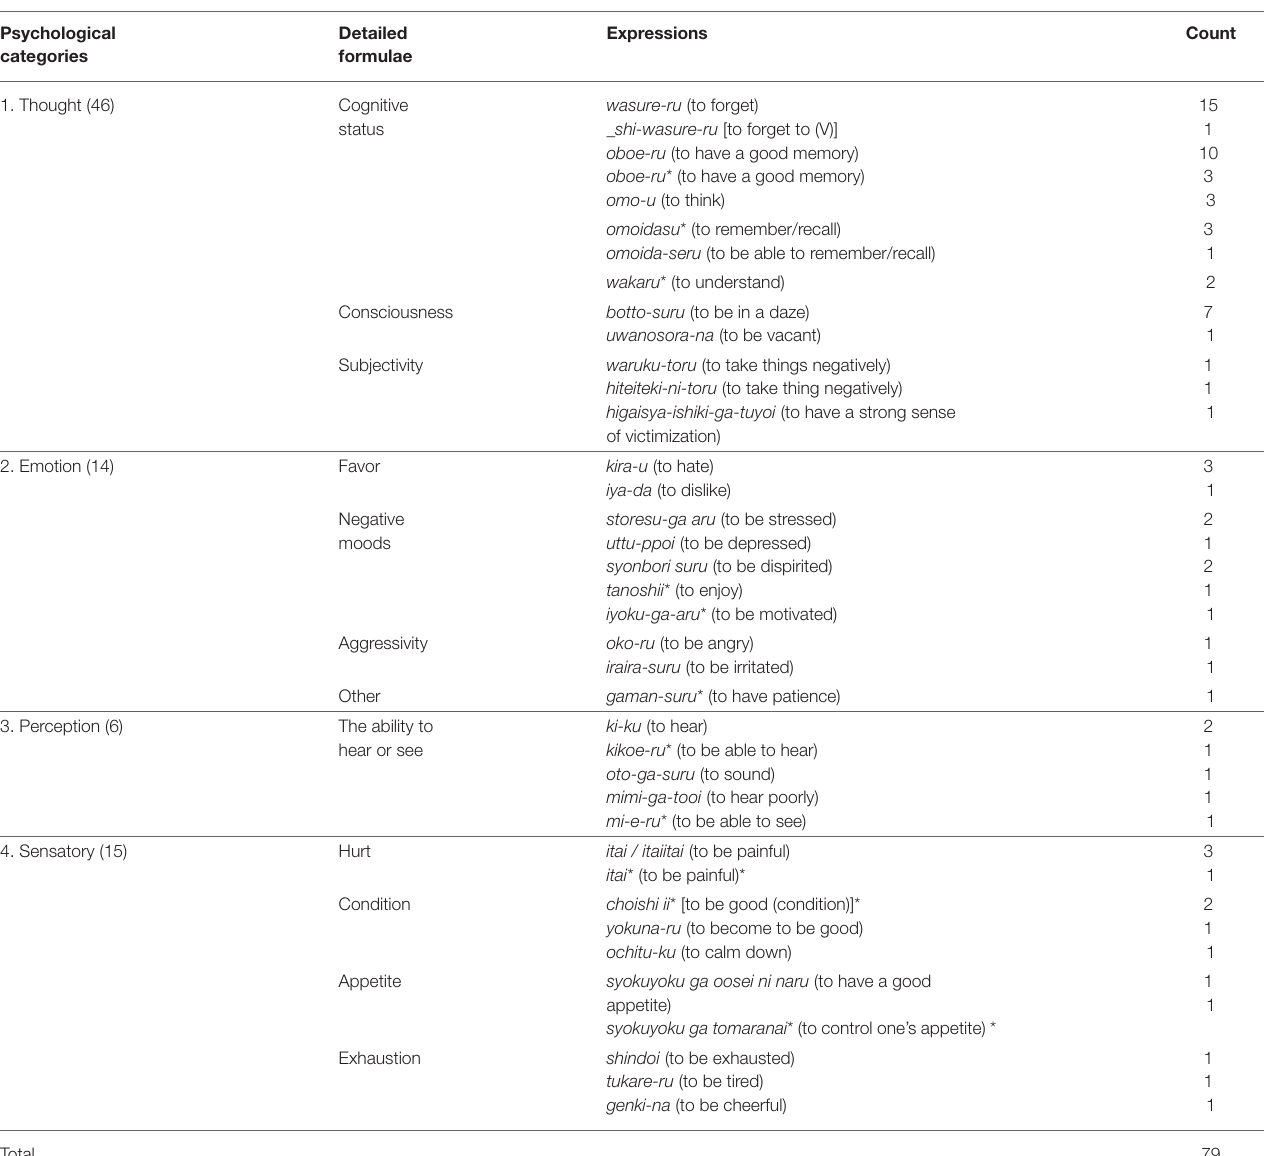
TABLE 3 | Negative psychological expressions used toward patients by